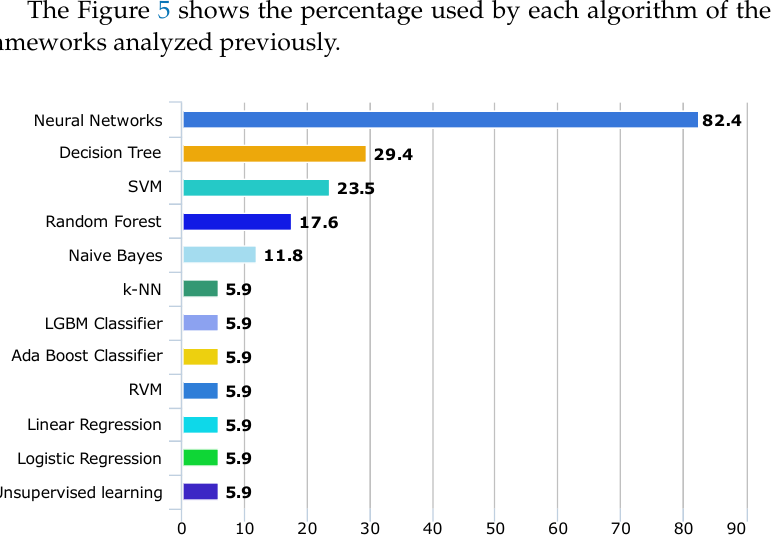
Figure 5. Percentage of use of different algorithms from the total of the frameworks previously